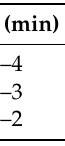
Table 5. Computational times